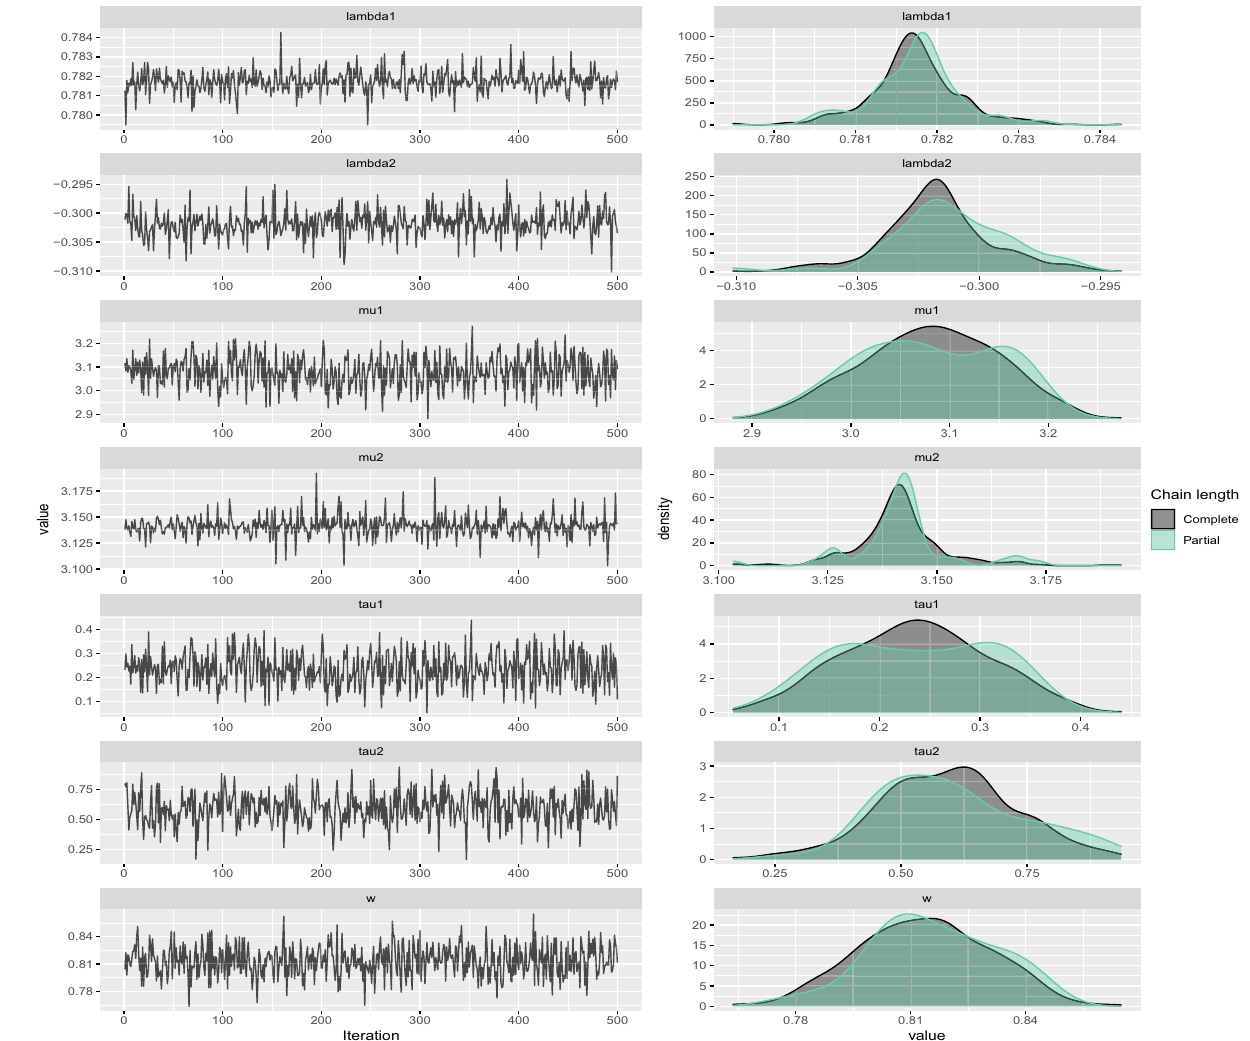
Figure 6. Traceplots and estimated posterior density plots of generated samples for ( w , µ 1 , τ 1 , (cid:31) 1 , µ 2 , τ 2 , (cid:31) 2 ) in Table 3 for n = 500 .